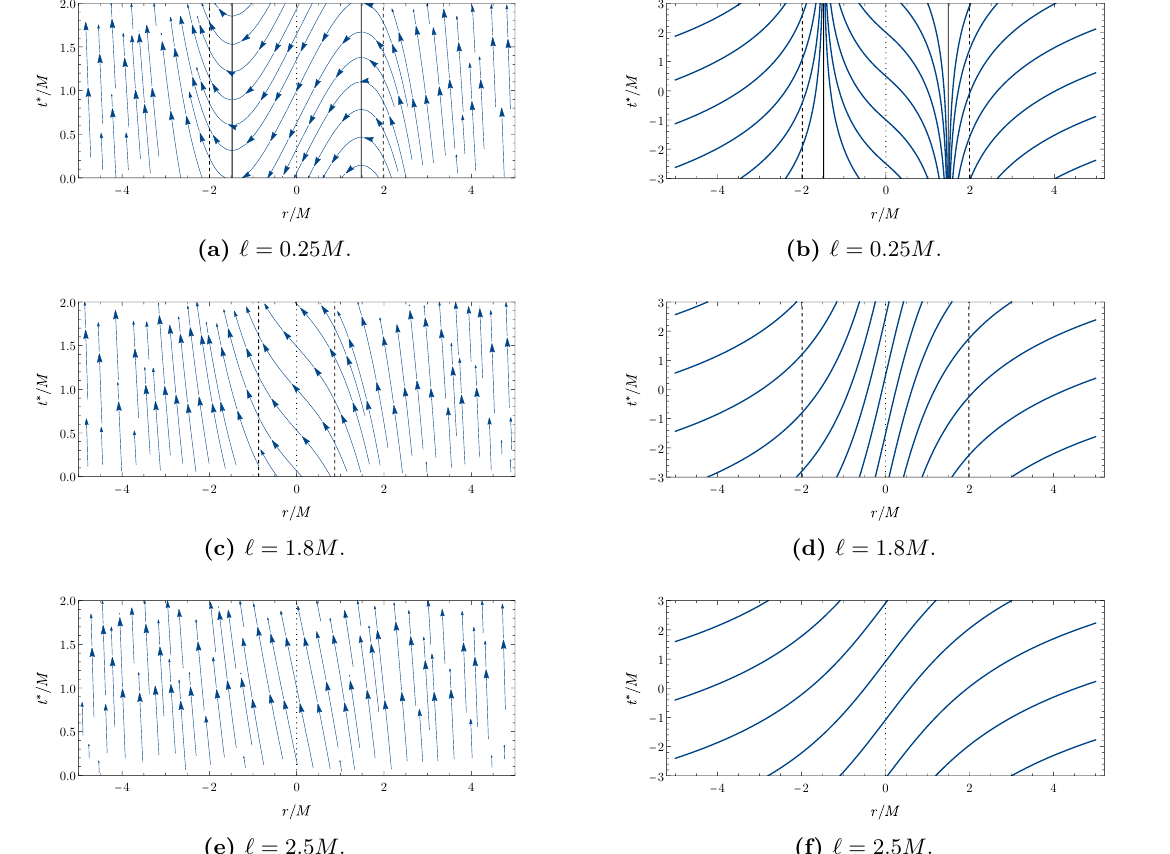
Figure 3. Black bounce: æther flow (left) and constant-khronon surfaces (right). Black solid lines mark universal horizons, dashed lines Killing horizons; the dotted line signals the mouth. the first row depicts a black bounce with a UH and a KH per side, the second row represents a configuration with just one with KHs per side but no UHs, the third row portraits a naked (without horizons) traversable